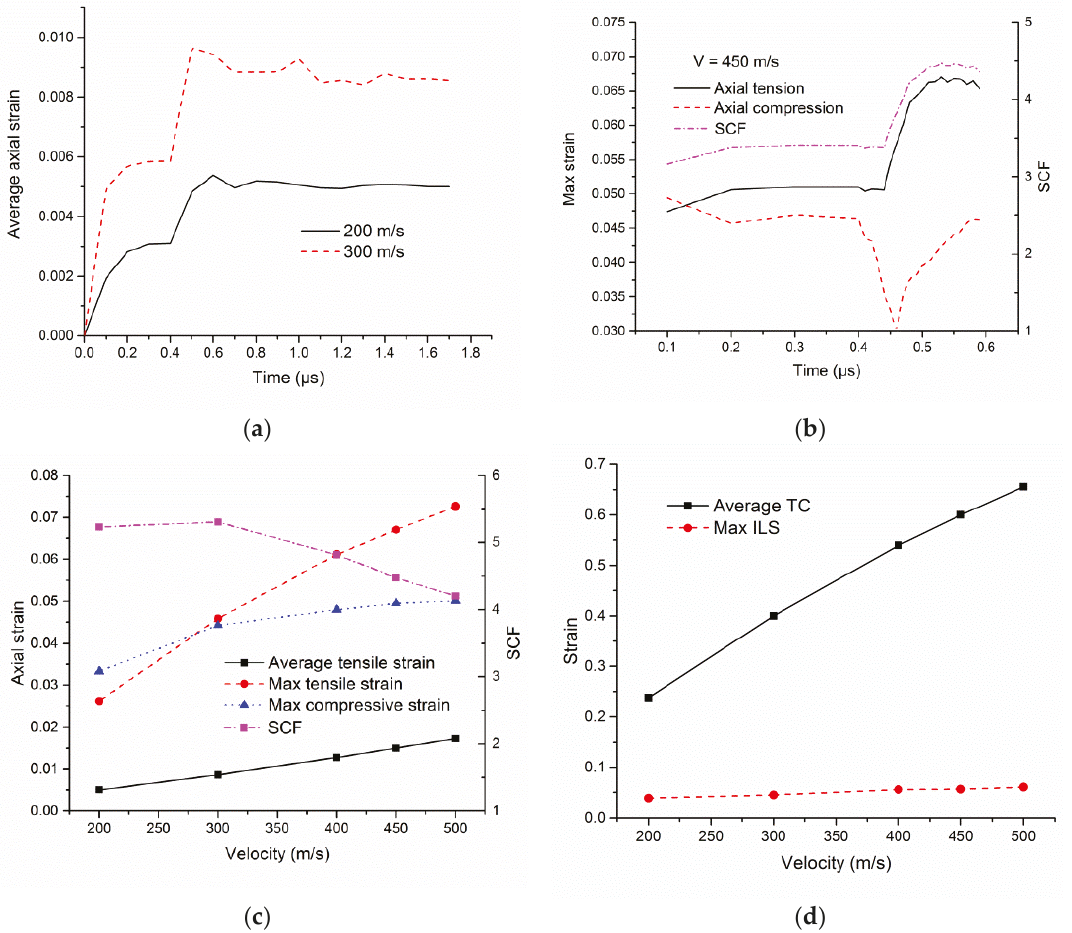
Figure 10. FSP impact inelastic fiber behavior: ( a ) evolution of average axial strains; ( b ) evolution of axial tensile and compressive strains; ( c ) axial strain and SCF as a function of velocity; and ( d ) TC strain as a function of velocity.